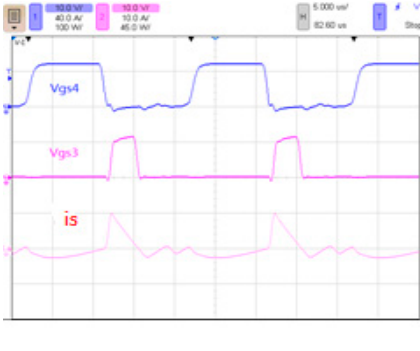
Figure 11. Measured waveforms under Stage 2 at half load: ( a ) switch S 1 waveform, ( b ) switch S 2 waveform, ( c ) primary-side current waveform of transformer, ( d ) charging inductor current waveform, ( e )switch S 3 waveform, ( f )switch S 4 waveform, and( g